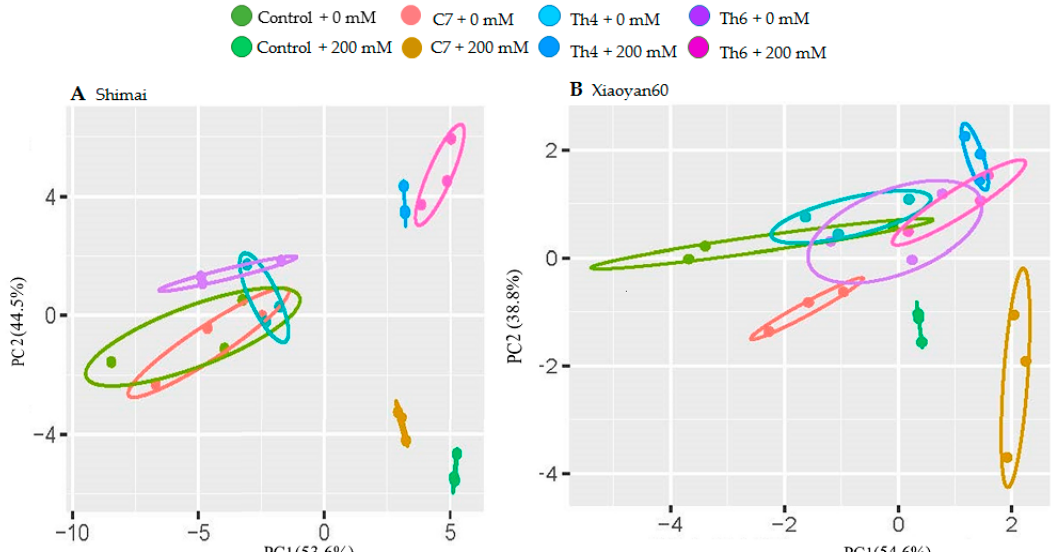
Figure 4. Results of two-dimensional principal component analysis (PCA) for photosynthetic gas exchange parameters in two wheat cultivars: ( A ) Shimai and ( B ) Xiaoyan60. Control + 0 mM and control + 200 mM are combinations of uncoated seed with 0 and 200 mM NaCl, respectively. C7 + 0 mM, Th4 + 0 mM, Th6 + 0 mM, C7 + 200 mM, Th4 + 200 mM and Th6 + 200 mM are combinations of seed coating treatments with C7, Th4, and Th6 under 0 and 200 mM NaCl, respectively.